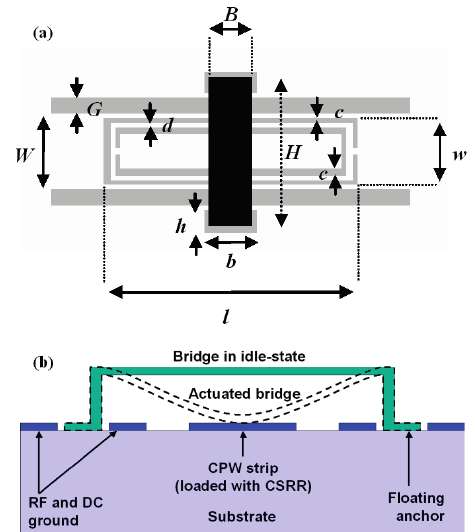
Figure 3. ( a ) Unit cell of the CSRR/RF-MEMS loaded coplanar waveguide (CPW), with slot regions of the CPW depicted in grey, and relevant dimensions; ( b ) cross section of a CPW with a RF-MEMS bridge. The down-state corresponds to the application of an actuation voltage to the strip line of the CPW; in the up-state, no actuation voltage is applied. From [17], reprinted with